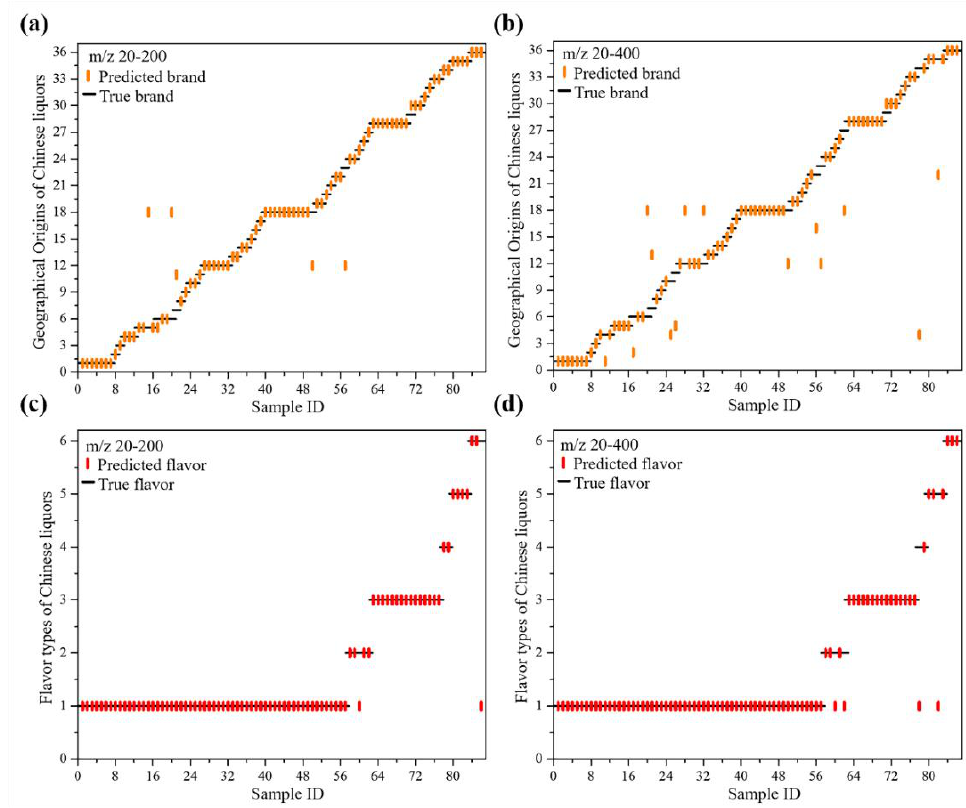
Figure 6. The output results of the SVM machine learning about thirty-six geographical origins of Chinese liquors ( a , b ), and six flavor types of Chinese liquors ( c , d ).